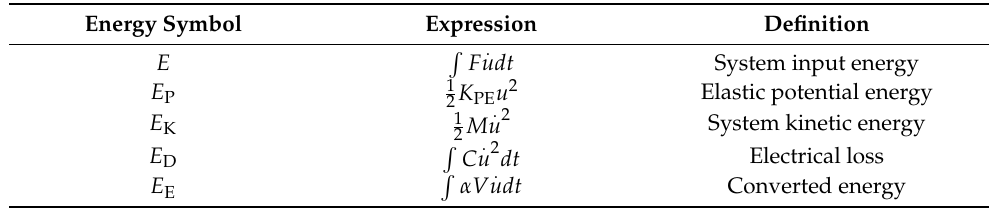
Table 1. Energetic terms